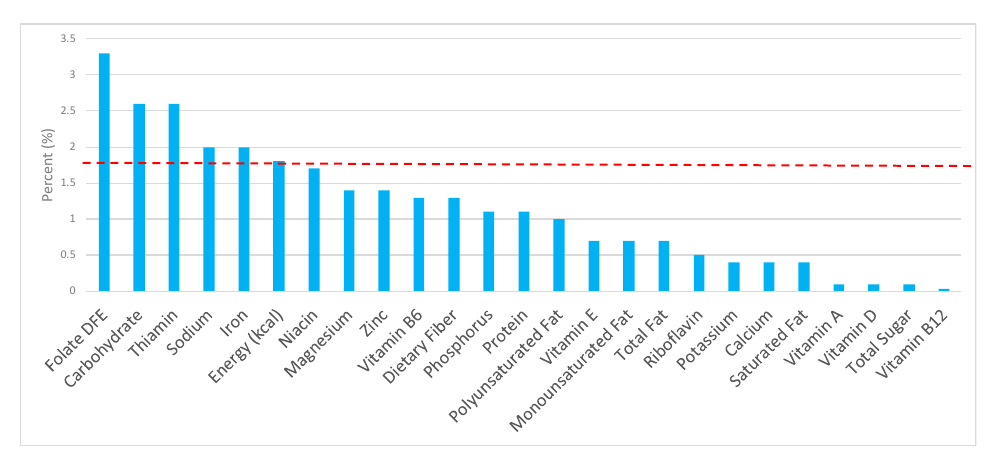
Figure 6. Cooked grains as sources of energy and nutrients using NHANES 2009–2012, for adult females. Data are for adult females aged ≥ 19 years of age ( n = 5349), Day 1 intakes; dashed red line represents the percentage of energy provided and nutrients that surpass energy (kcal) contribution. Thus, nutrients above the dashed red line show the food category provides a greater percentage in the diet to showcase meaningful nutrient density in the diet per day.